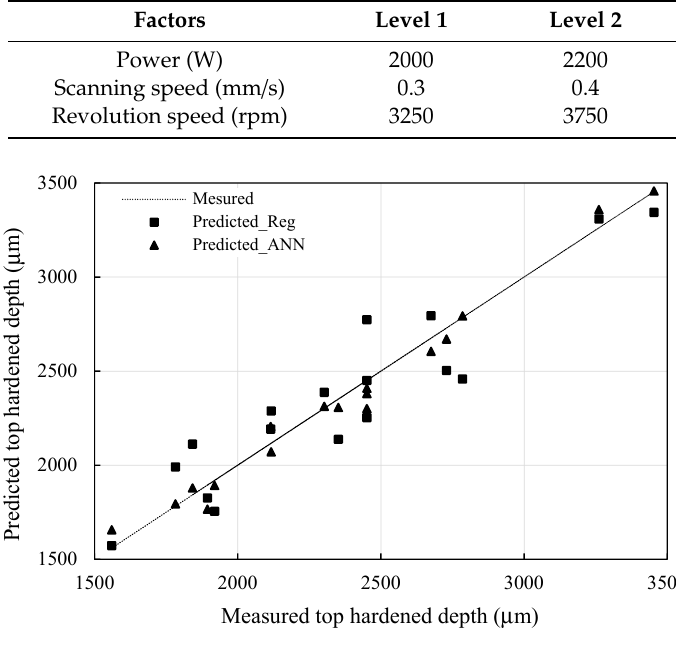
Figure 14. Measured and predicted tooth top hardened depth.